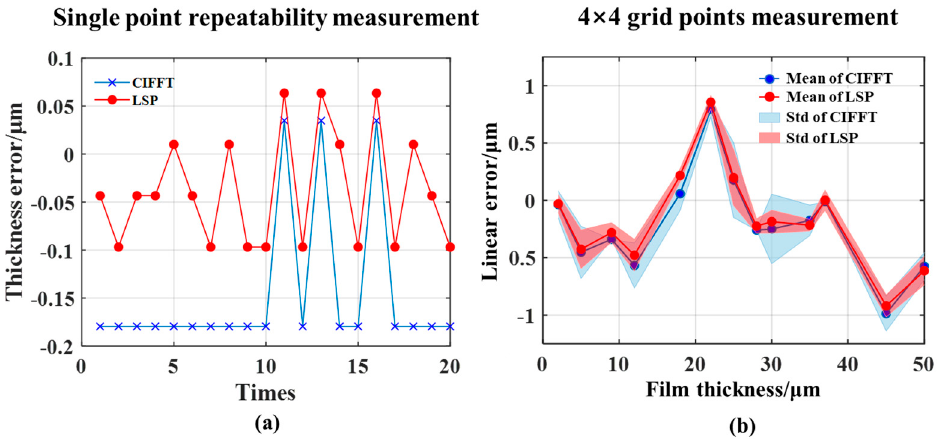
Figure 10. Comparison of the result of CIFFT and LSP algorithm for standard film ( a ) Single point repeatability measurement; ( b ) 4 × 4 grid points measurement.